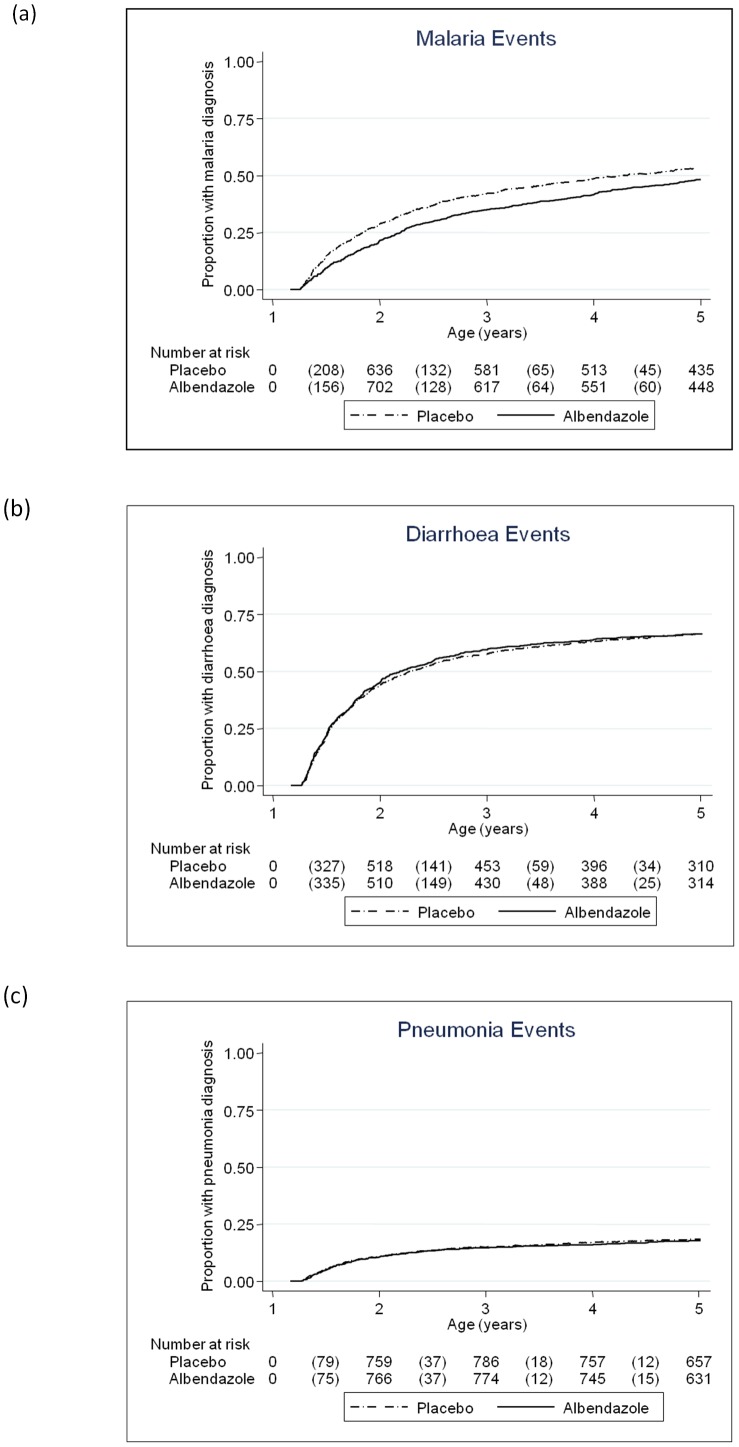
Effect of quarterly albendazole from age 15 months to 5 years on infectious disease incidence in children.Kaplan-Meier survival estimates for time to first (or only episode) of (a) malaria, (b) diarrhoea and (c) pneumonia during the intervention period, comparing children who received quarterly albendazole with those who received placebo. Numbers shown in the tables are number of events (in brackets) and number of children at risk.